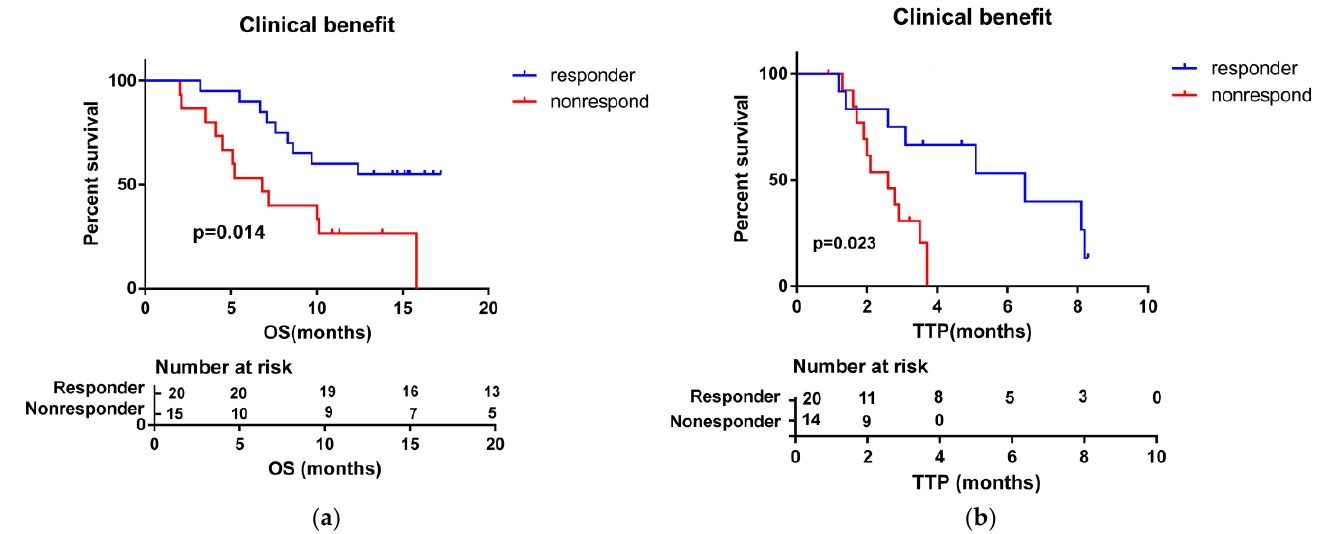
Figure 2. Kaplan–Meier curves for overall survival (OS) ( a ) and TTP ( b ) for patients with clinical benefits (CR + PR + SD) and without clinical benefits (PD) in HCC patients treated with HAICROX, who experienced TACE treatment failure or